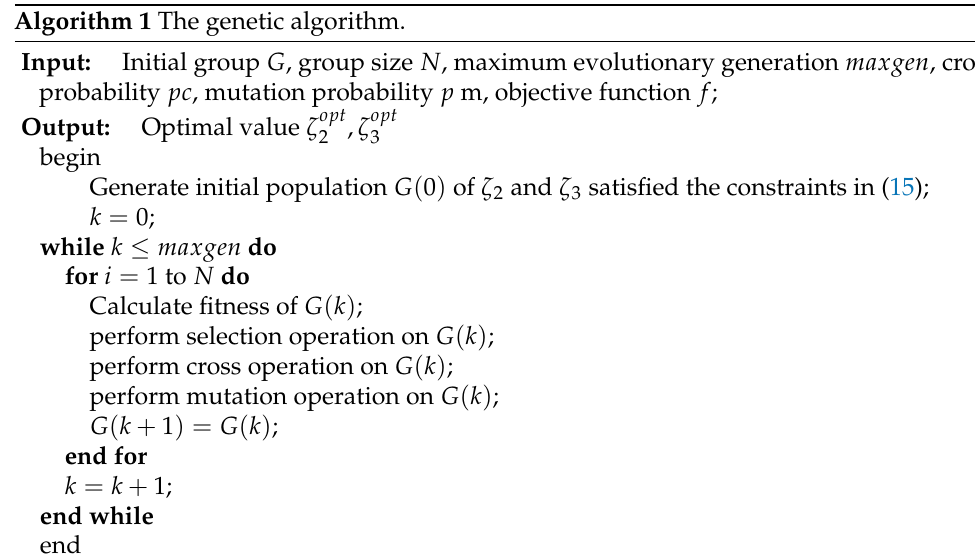
Algorithm 1 The genetic algorithm.